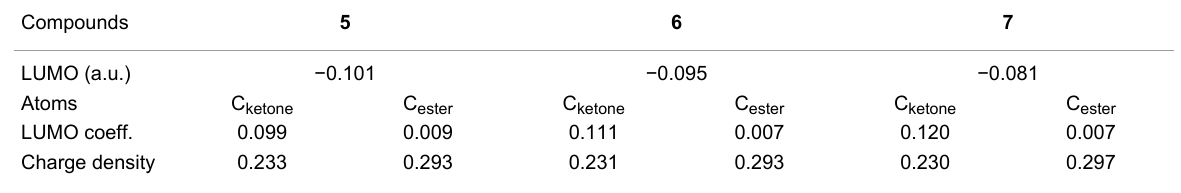
Table 6: . LUMO coefficients and charge densities for the selected atoms in compounds 5–7 obtained by DFT-B3LYP calculations. Compounds 5 6 7 LUMO (a.u.) − 0.101 − 0.095 − 0.081 Atoms C ketone C ester C ketone C ester C ester LUMO